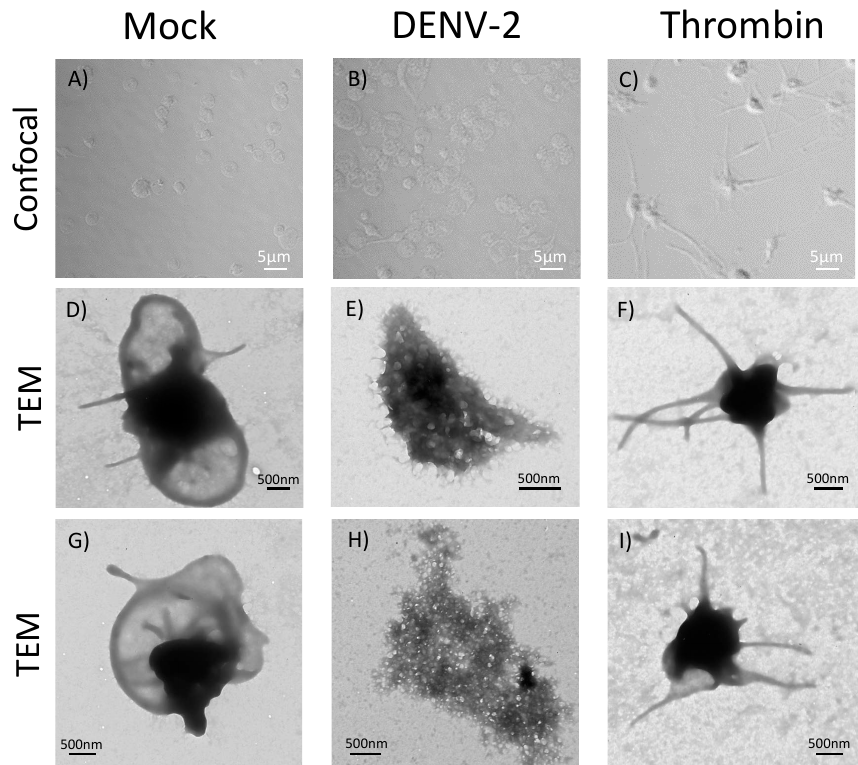
Figure 6. DENV-2 induced conspicuous morphological changes in human platelets. Platelets stimulated with DENV-2, MOI 0.2 ( B ) and MOI 0.5 ( E , H ) for 4 h, mock (and thrombin were incubated at 37 ◦ C, and analyzed by TEM in triplicate. A representative image of the observed changes is presented. Conspicuous morphological changes occur in DENV-2-treated platelets ( B , E , H ), very different to those observed in thrombin positive control ( C , F , I ), meanwhile, mock control showed a normal platelet morphology ( A , D , G ). Images were captured at 50,000 × . Duplicate assays were independently repeated three